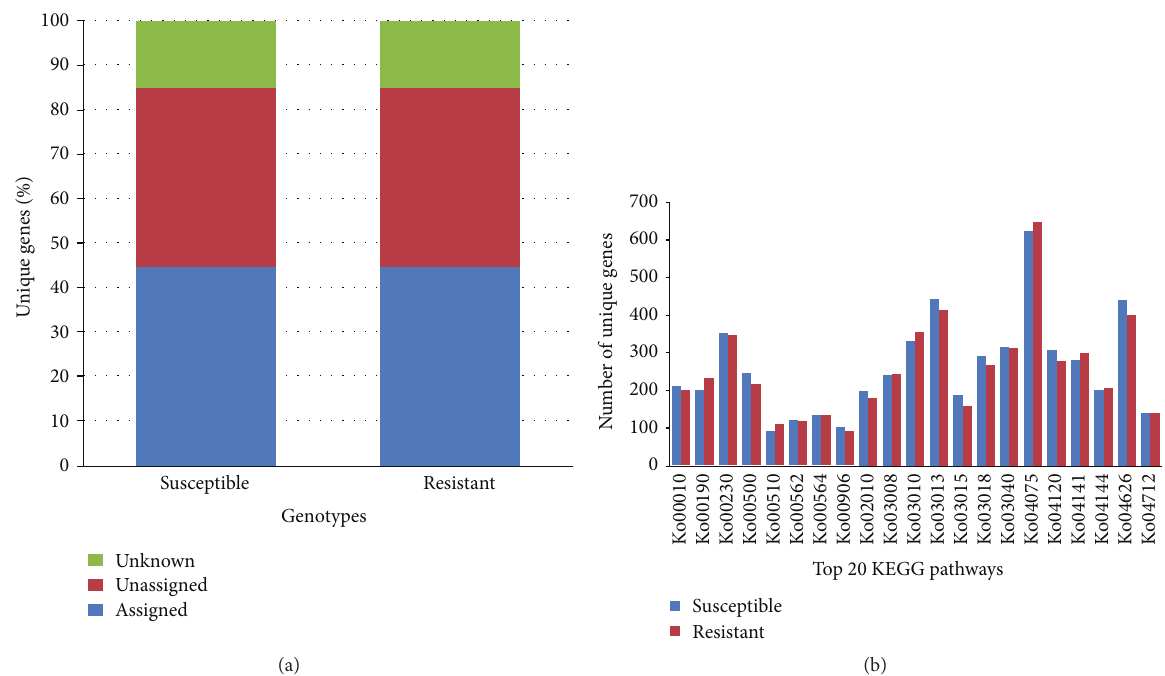
Figure 2: Distribution of active genes in two Lagerstroemia indica cultivars: powdery mildew susceptible (“Carolina Beauty,” CAB) and powdery mildew resistant (“Natchez,” NAT) transcriptomes. (a) KEGG database based gene annotation. (b) Top 20 active KEGG pathways based on the number of